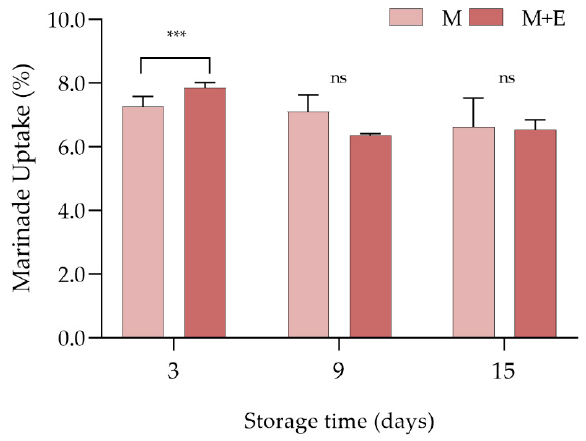
Figure 3. Average marinade uptake (%) values of marinated (M) and marinated with essential oils (M + E) pork loin slices at 3, 9 and 15 days of refrigerated storage. Data represent means ± SD. *** = p < 0.001. At the same storage time, ns indicates no significant differences among the samples.